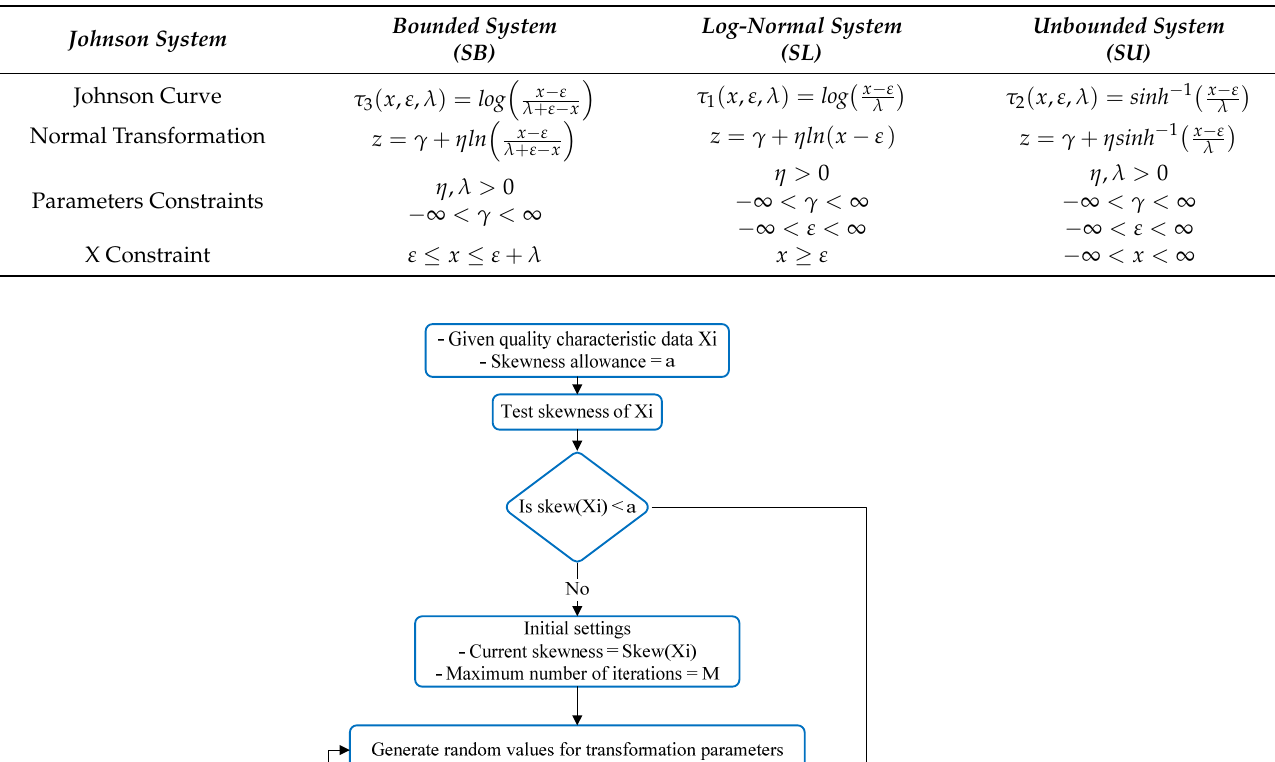
Table 3. Johnson transformation system [41].